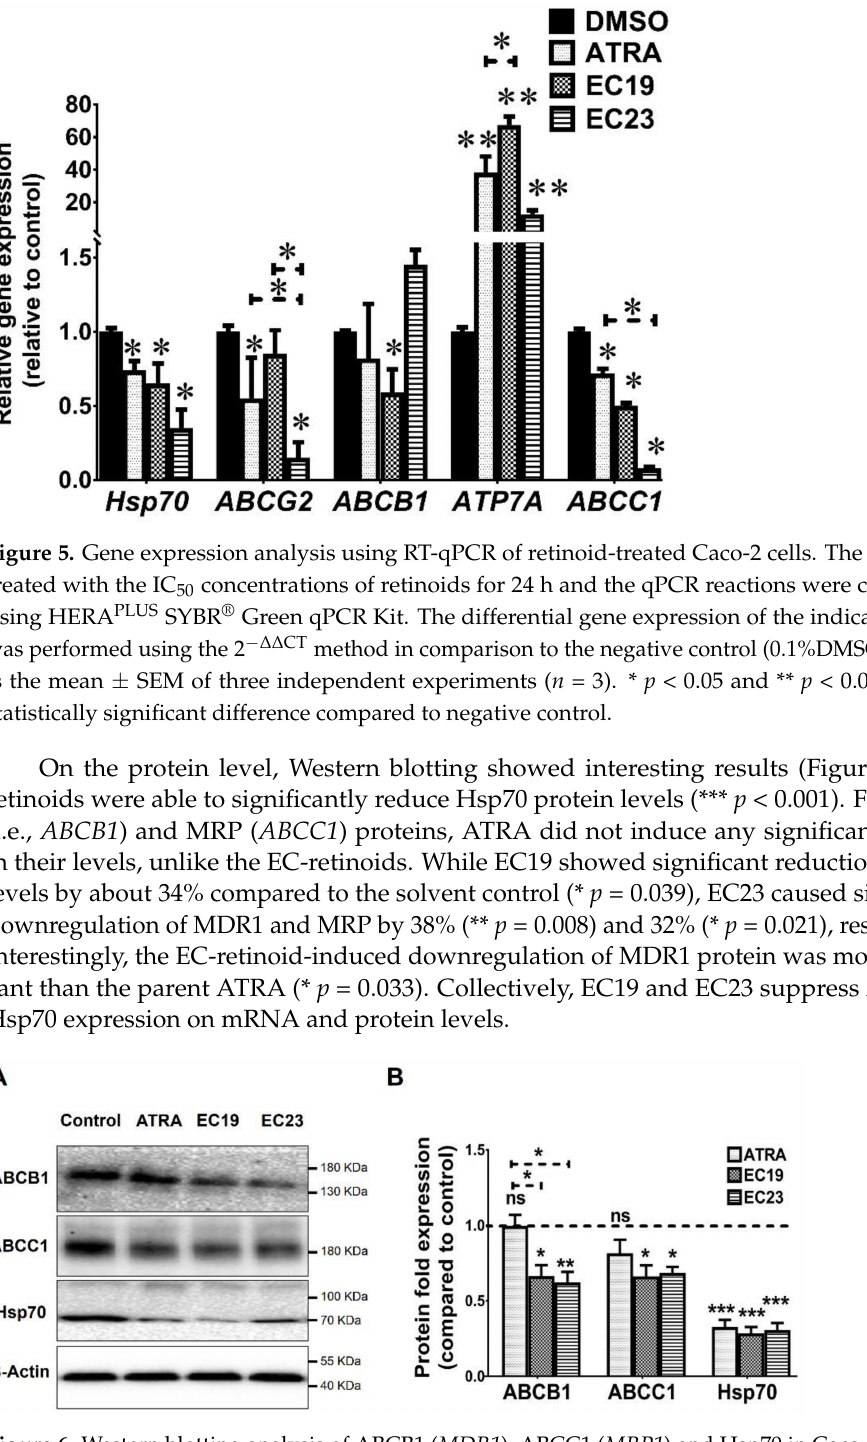
Figure 6. Western blotting analysis of ABCB1 ( MDR1 ), ABCC1 ( MRP1 ) and Hsp70 in Caco-2 cells. ( A ) Representative immunoblotting images demonstrate the effect of IC 50 dose of ATRA, EC19, and EC23 on the expression levels of the indicated proteins in Caco-2 cells treated for 24 h. The expression of the investigated proteins in treated Caco-2 cells was calculated and normalized to the β -actin protein level in each treated sample, and finally plotted as ( B ) the mean protein fold change from negative control (0.1%DMSO) (dotted line) ± SEM. It can be clearly seen that EC19 and E23 caused significant downregulation of all proteins in comparison to the 0.1% DMSO control. * p < 0.05, ** p < 0.01 and *** p < 0.001 indicate a statistically significant difference. ns;